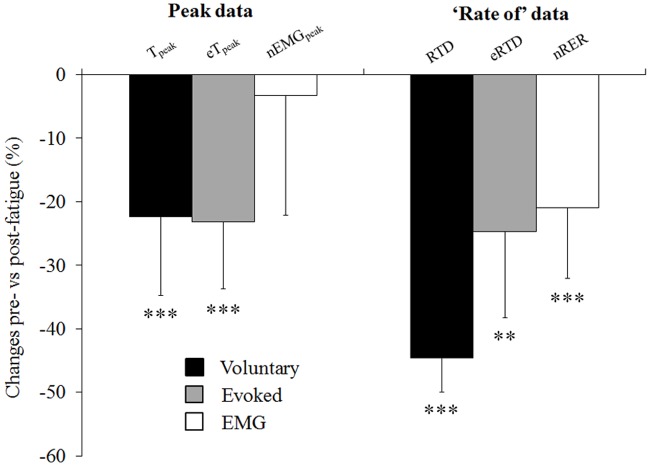
Changes pre- vs. post-fatigue for peak and ‘rate of’ data.Tpeak: voluntary peak torque; eTpeak: evoked peak torque; nEMGpeak: peak EMGrms normalized with Mmax; RTD: voluntary rate of torque development; eRTD: evoked rate of torque development; nRER: rate of EMG Rise normalized with Mmax. Data are mean ±SD. Significant changes post- vs pre-fatigue: *: p<0.05, **: p<0.01, ***: p<0.001.